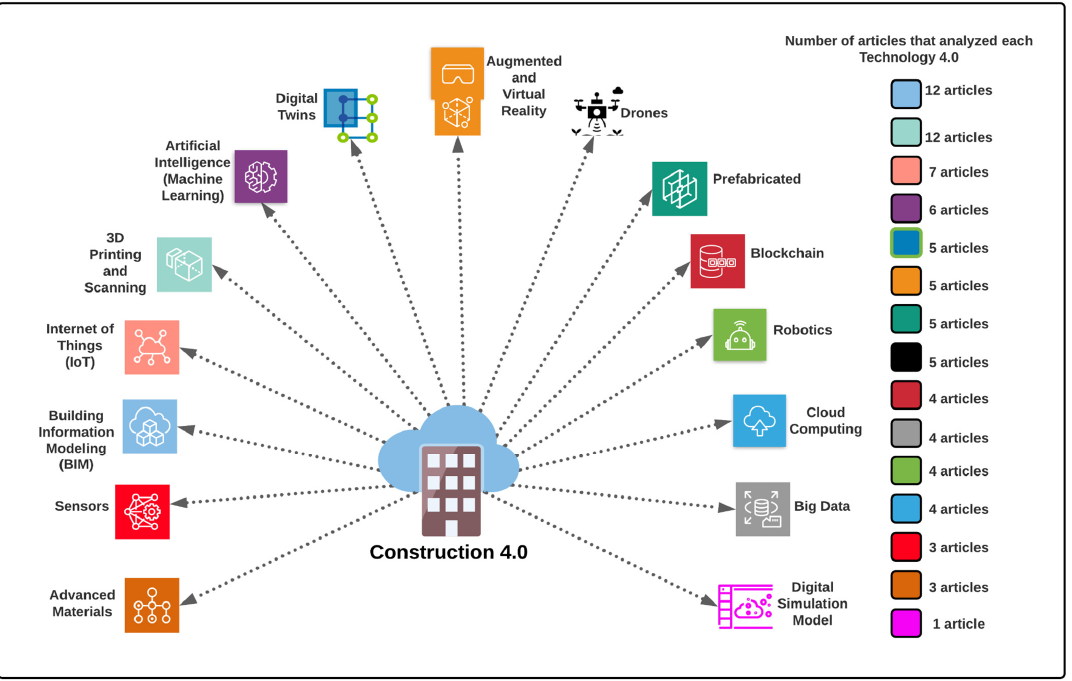
Figure 5. Technological contributions to civil construction. Source: Own elaboration supported by Lucidchart Educational Software, 2021.